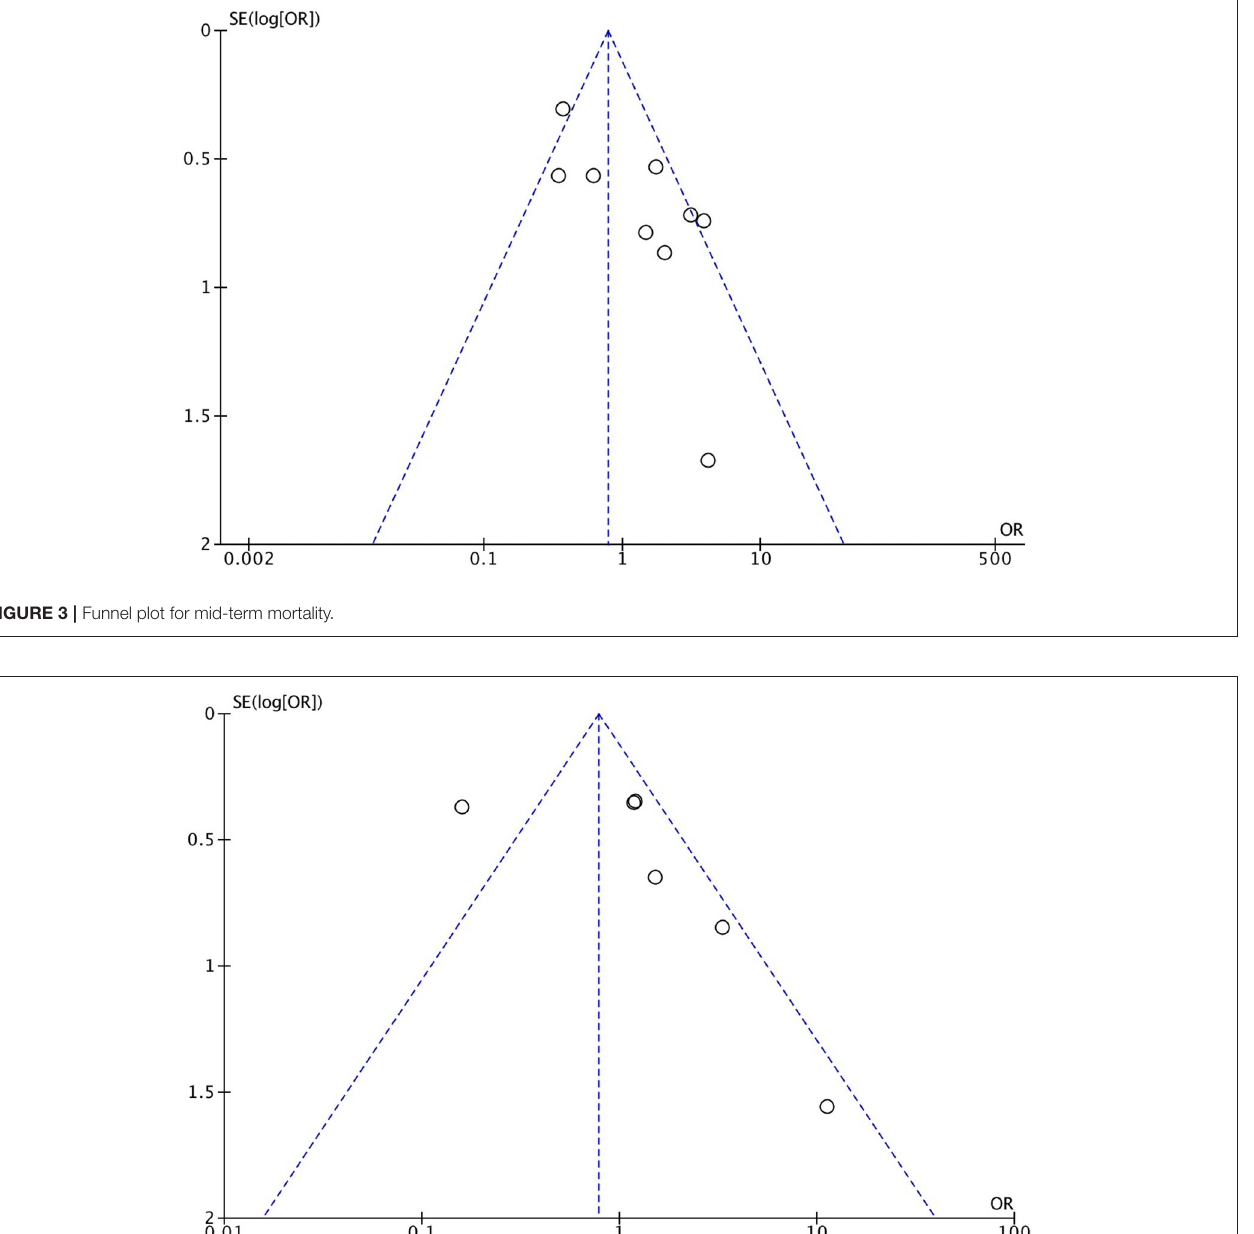
FIGURE 4 | Funnel plot for long-term